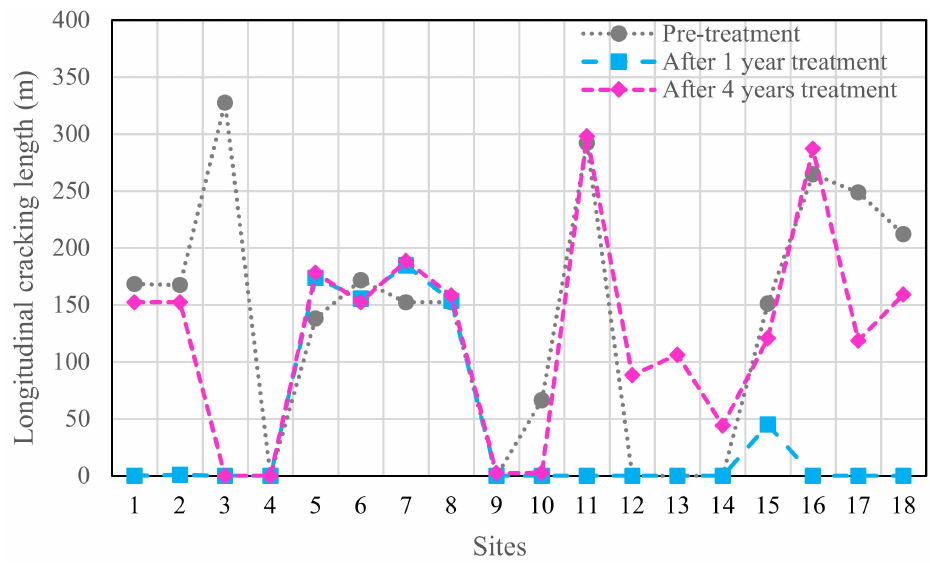
Figure 8. EffectivenessofWMAoverlaycontainingRAPforlongitudinalcrackingunderdryclimaticconditions.